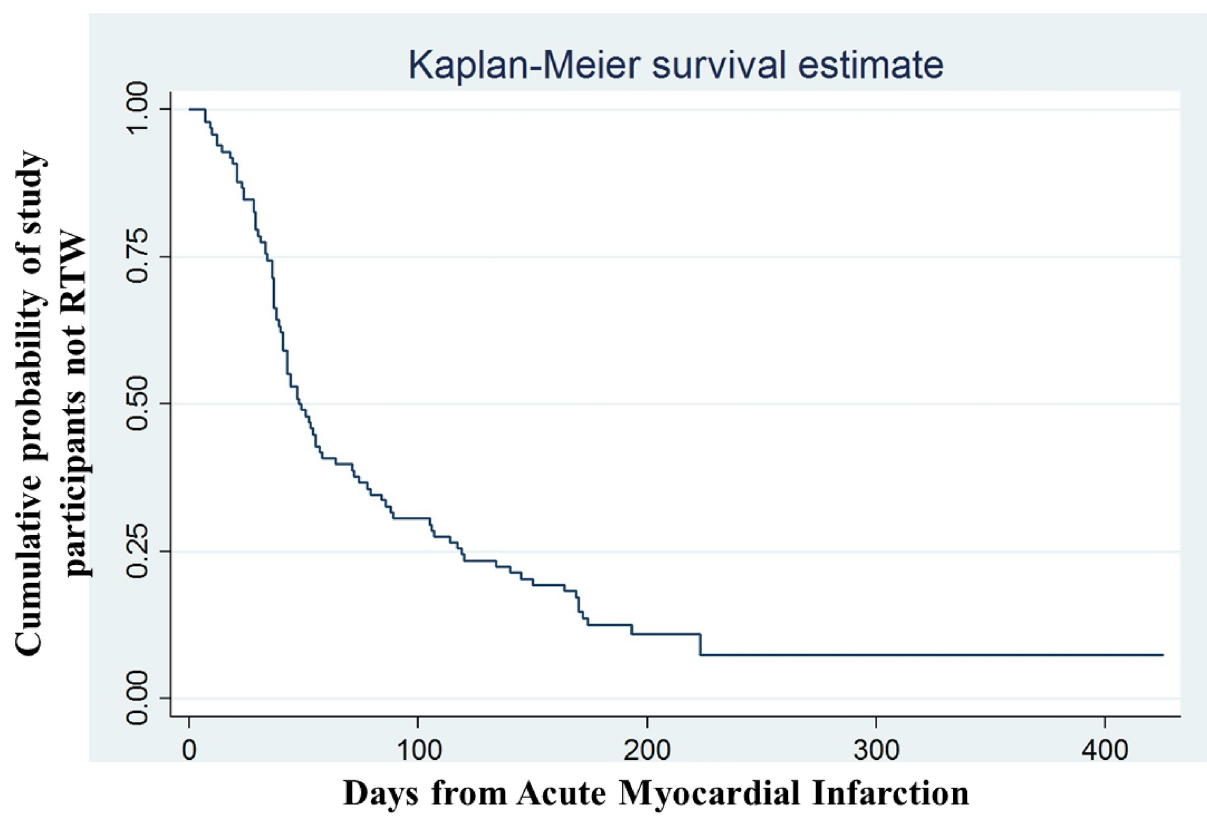
Fig 1. Rate of no return to work status (RTW) in the study patients during the 12 month follow-up.